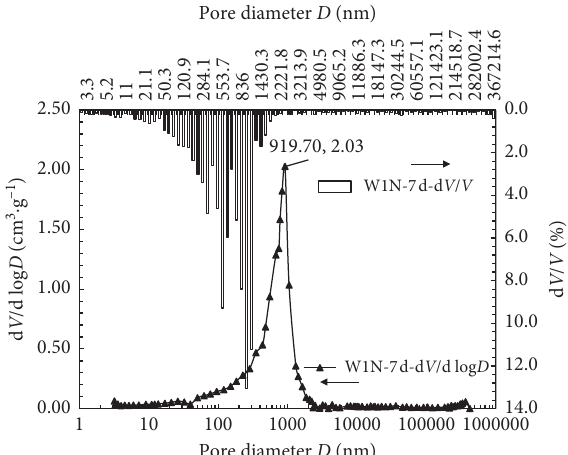
Figure 11: Pore-diameter distribution of 7-day-old W1 N con- cretion by MIP